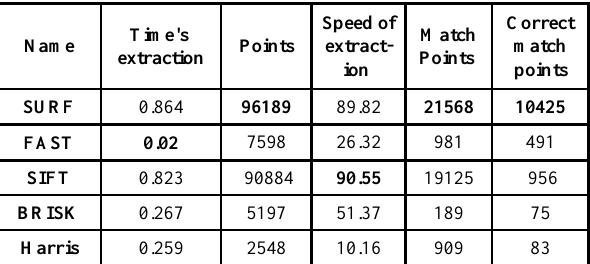
Table 2. Comparison of point extraction algorithms, data set 1